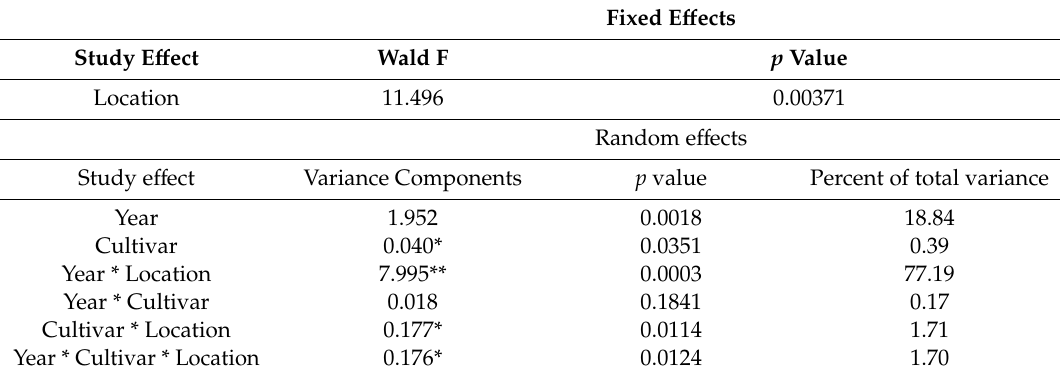
Table 3. The Wald F ratio for fixed e ff ects and variance components with their percentage share in the total variation of random e ff ects for the white sugar